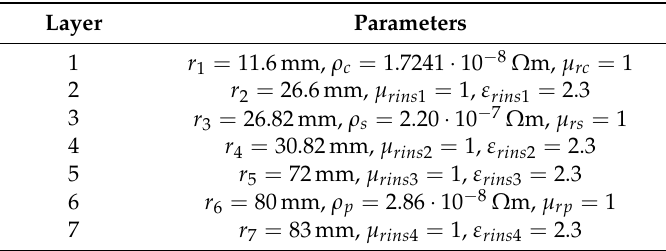
Table 3. Geometrical and material parameters for Case Study #1. Figure 4. Cable cross-section for Case Study #1 and installation conditions (laying depth and surrounding medium properties).